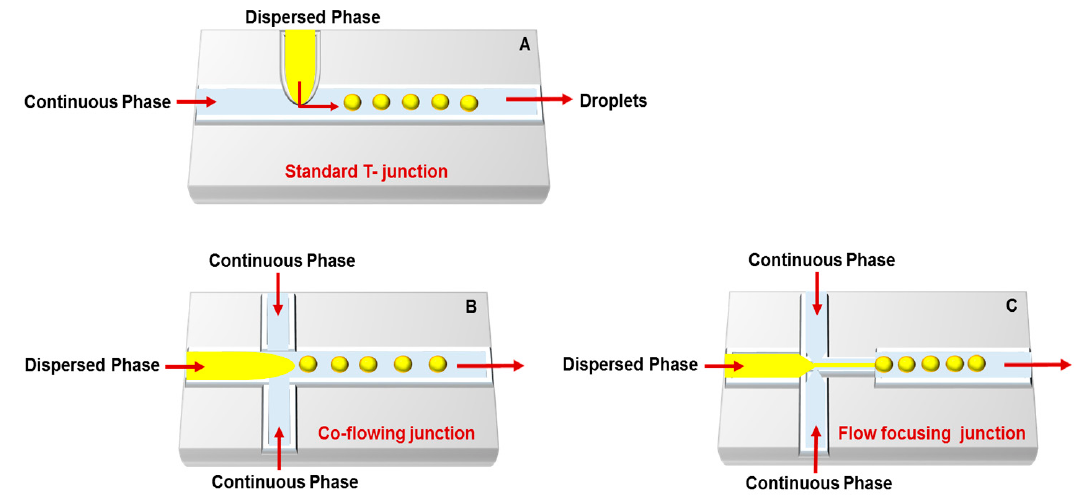
Figure 2. Droplets microfluidic platforms for generation of drug and gene carriers: ( A ) T-junction; ( B ) co-flowing junction; and ( C ) flow-focusing junction. Dispersed phase consists of divided droplets that suspended in the continuous phase Figure modified from References [44,45].